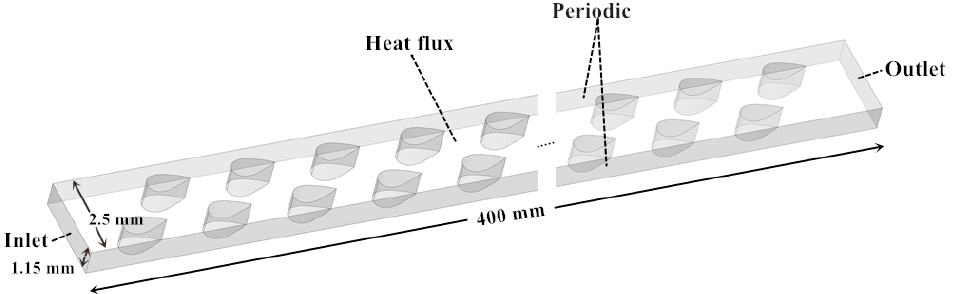
Figure 2. Schematic diagram of the computational model.